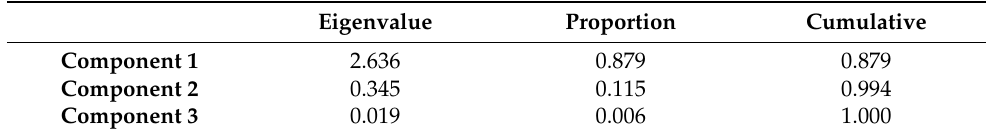
Figure 3. Variance inflation factor results of the RGB. Table 5. Eigenvalues derived from the principle component analysis.